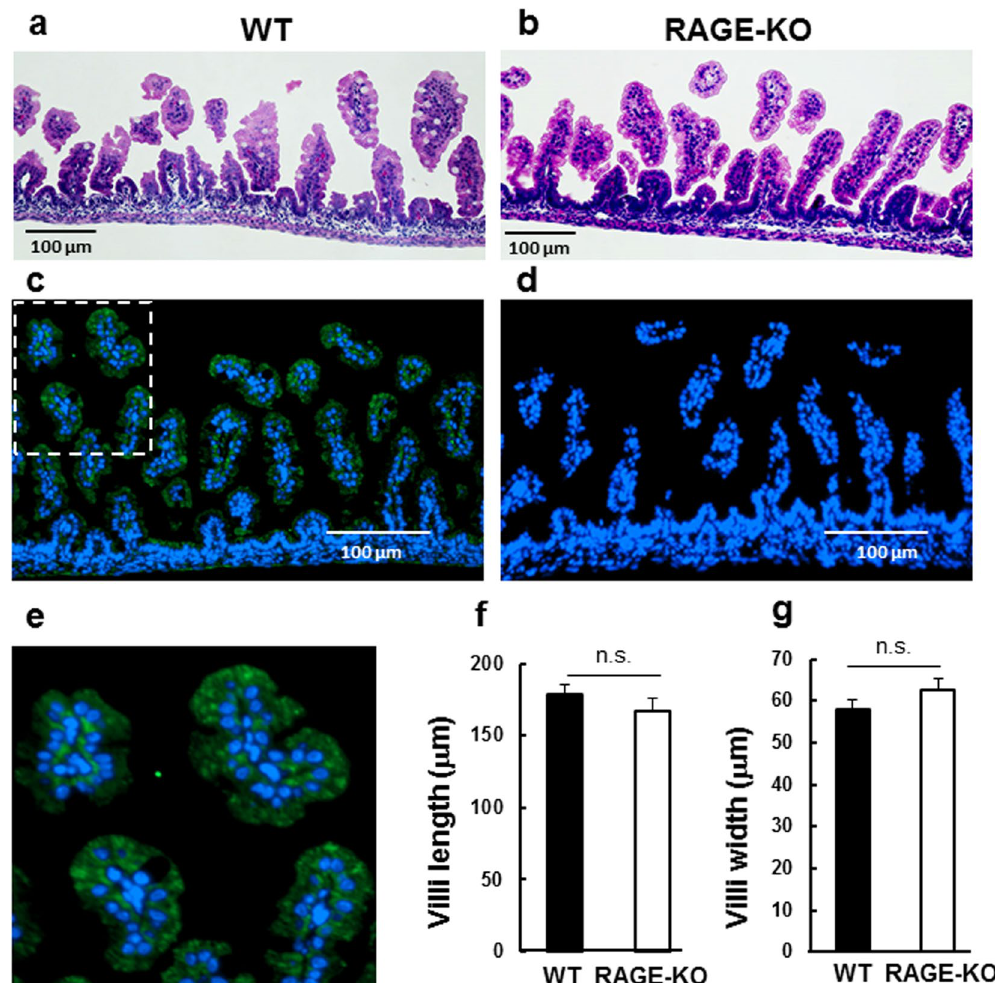
Figure 8. RAGE in the intestine. ( a and b ) Small intestines from 3-day-old wild-type (WT) and Ager − / − (RAGE KO) mice were isolated, fixed with 4% paraformaldehyde, and paraffin embedded. Sections (4 μ m) were stained with haematoxylin and eosin. ( c and d ) Sections of the intestines of PND3 WT ( c ) and RAGE KO ( d ) mice were immunostained with an anti-RAGE antibody (green); the nuclei were stained with DAPI. Bar = 100 μ m. Co-staining of RAGE with DAPI indicates that RAGE is present in the intestinal villi in an enlarged image ( e ). ( f and g ) Morphological parameters such as villus length and villus width were measured from images with haematoxylin and eosin staining. Note that there were no significant differences in these parameters between the two groups N =